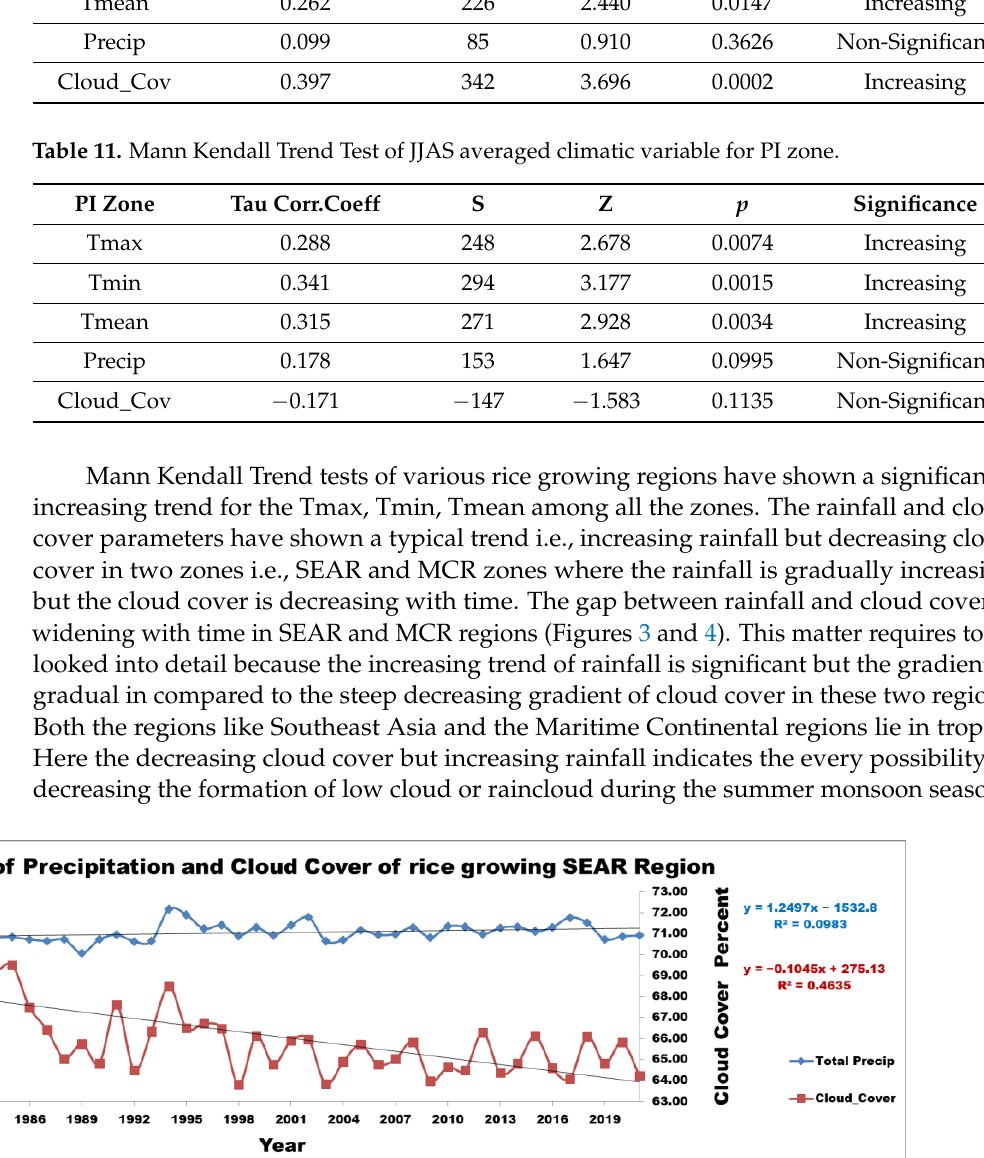
Figure 4. Trend of Precipitation and Cloud Cover for MCR region. Rice suitable and non-suitable climate trends have been assessed based on simple rule of cardinal temperatures [22] lying within base temperature (Tbase) 10° C and maxi- mum temperature (Tmax) 38 °C and precipitation 100 cm or more. The above rice climate suitable condition has been screened year-wise for 42 years and the score of the same has been prepared. It has been found that MCR and IGP zones followed by SEAR zone have witnessed the most rice suitable climate with MCR and IGP zones facing the best score in rice climate suitability. (Table 12 and Figure 5)